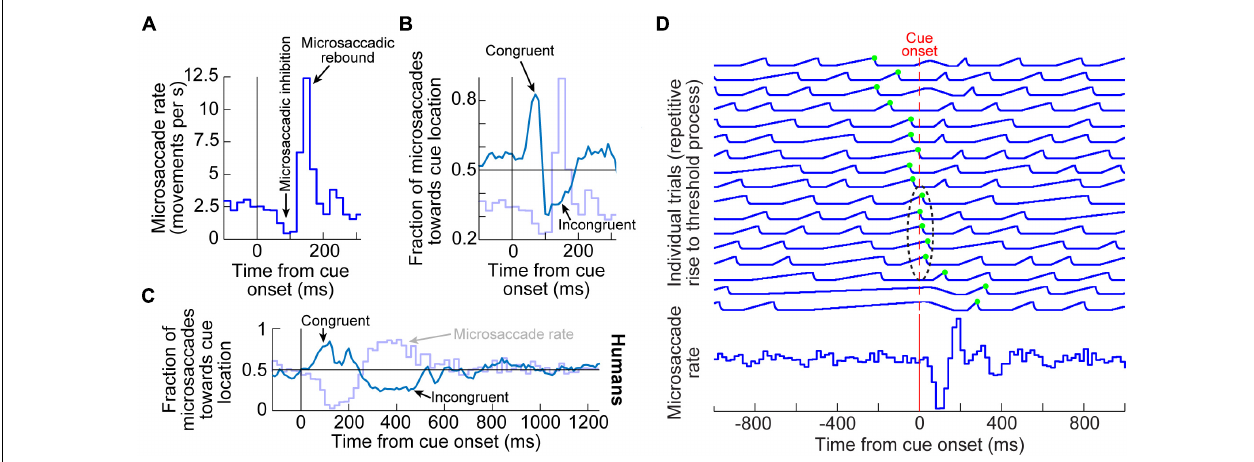
FIGURE 1 | Systematic modulation of microsaccades after peripheral cue onsets. (A) Microsaccade rate from one monkey as a function of time from cue onset. In a baseline interval (e.g. before the cue), microsaccades come at a steady rate. Less than 100 ms after cue onset, microsaccade rate abruptly decreases (microsaccadic inhibition). A later rebound above baseline microsaccade rate then occurs, before a subsequent return to steady-state frequency. (B) The distribution of microsaccade directions relative to peripheral cue onset location is also time varying, and in a manner that is related to the microsaccadic rate modulations [the faint curve shows microsaccade frequency from (A) as a reference]. At the onset of microsaccadic inhibition, microsaccade directions are strongly biased toward the cue location (congruent microsaccades). Shortly afterward, at the onset of the rebound phase, microsaccades are strongly biased opposite the cue direction (incongruent microsaccades). (C) Human microsaccades show very similar modulations, but with slower temporal dynamics. (D) Mechanistically, the effects in (A–C) may reflect a resetting of ongoing microsaccade generation rhythms. Each fixation trial may be viewed as a repetitive rise-to-threshold process; a microsaccade is triggered at every threshold crossing (green dots indicate the time of the nearest microsaccade to stimulus onset). Cue onset resets the rise-to-threshold process, such that across trials, the modulations in (A–C) can emerge (bottom histogram for the case of microsaccade rate). Note how the trials highlighted with the black oval are trials in which cue onset comes too late to successfully reset the currently ongoing microsaccade rise-to-threshold process, resulting in very early microsaccades after cue onset. This theoretical framework suggests that cued-induced microsaccadic modulations depend on specific sensory and motor structures contributing specific components of the modulations in (A–C) , as we review in this article. (A,B,D) adapted with permission from Hafed and Ignashchenkova (2013); (C) adapted with permission from Tian et al.